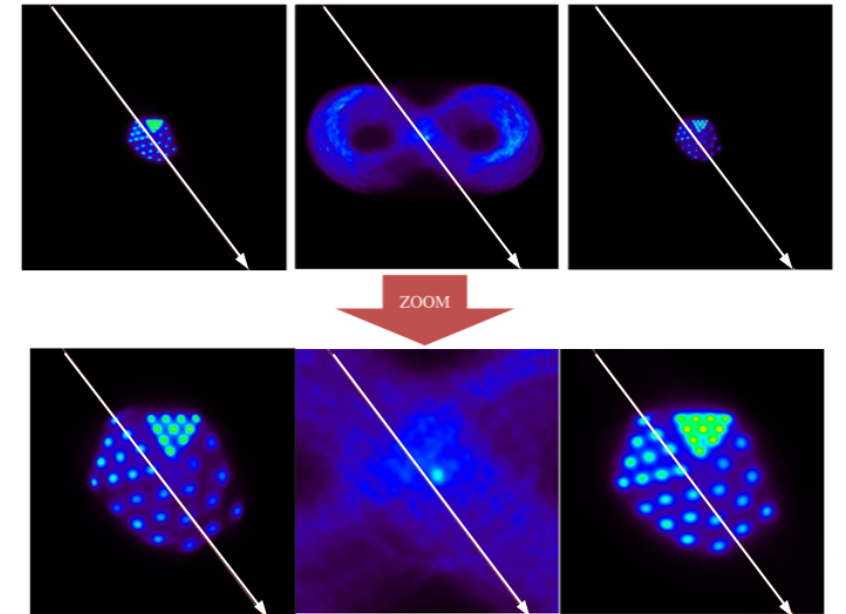
Figure 12. Static image, uncorrected and corrected in the 2D experiment with the Derenzo phantom. ( Top ): original size of the images. ( Bottom ): close up of the images for better visualization. The central image shows the motion followed by the phantom (Bernoulli’s lemniscate).